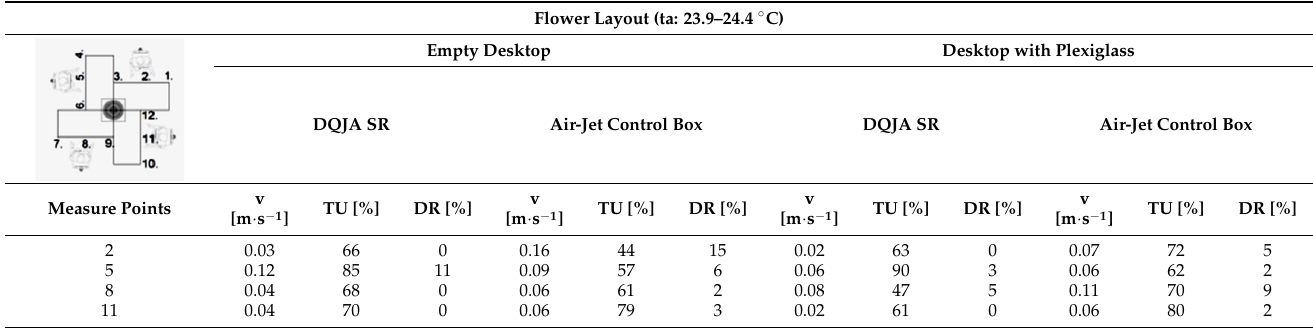
Table 4. Airflow status indicators at the Flower setup.